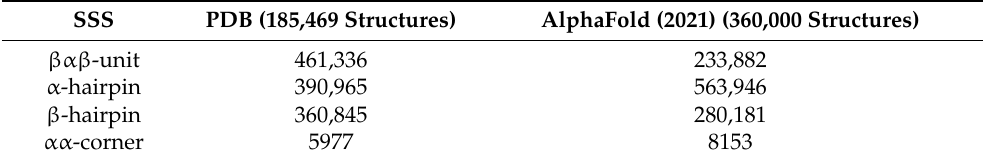
Table 1. Number of SSSs recognized in open knowledge databases (PDB and